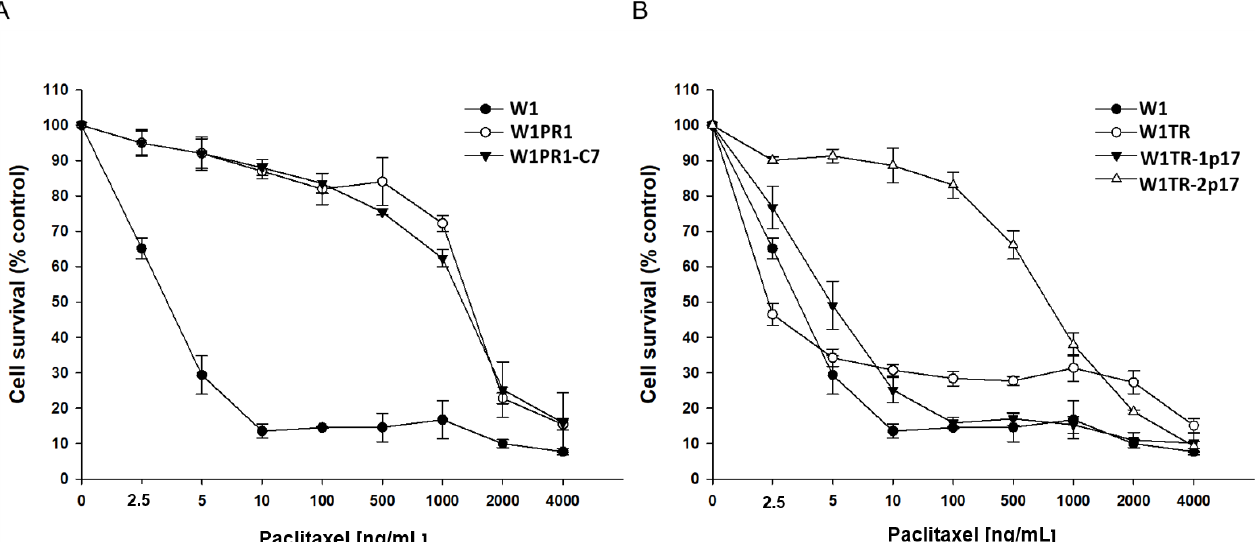
Figure 7. MTT cell survival assay in 2D cell culture conditions in W1, W1PR1 and W1PR1-C7 cell lines ( A ) and W1, W1TR, W1TR-1p17, W1TR-2p17 cell lines ( B ). Cells were seeded in 96-well plates and treated with or without increasing concentration of PAC (paclitaxel) at 37 ◦ C for 72 h and viability of cells was determined. The experiments were repeated at least three times and each concentration was tested in triplicate in each experiment. Viability was expressed as a percentage on an untreated control (mean ± SEM).